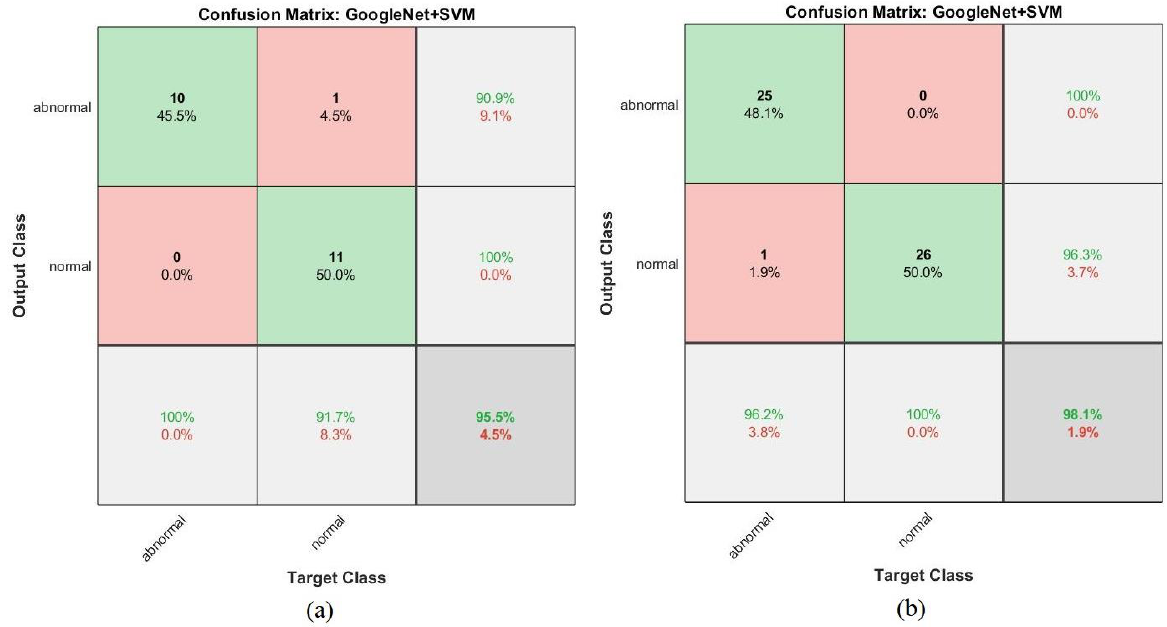
Figure 27. Confusion matrix for the GoogLeNet + SVM hybrid technique for the ( a ) ALL_IDB1 and ( b ) ALL_IDB2 datasets.